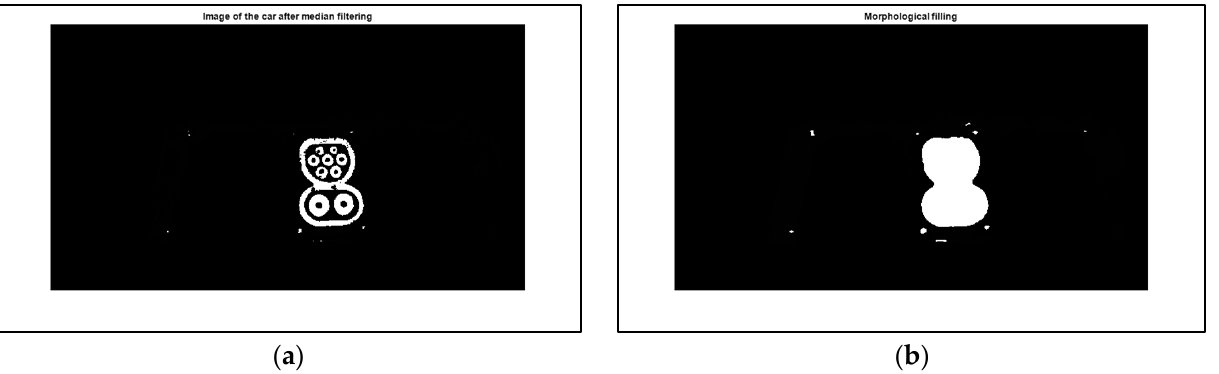
Figure 6. ( a ) Result of the median filtering and ( b ) result of the sequence of morphological pro- cessing and filling operation. and filling